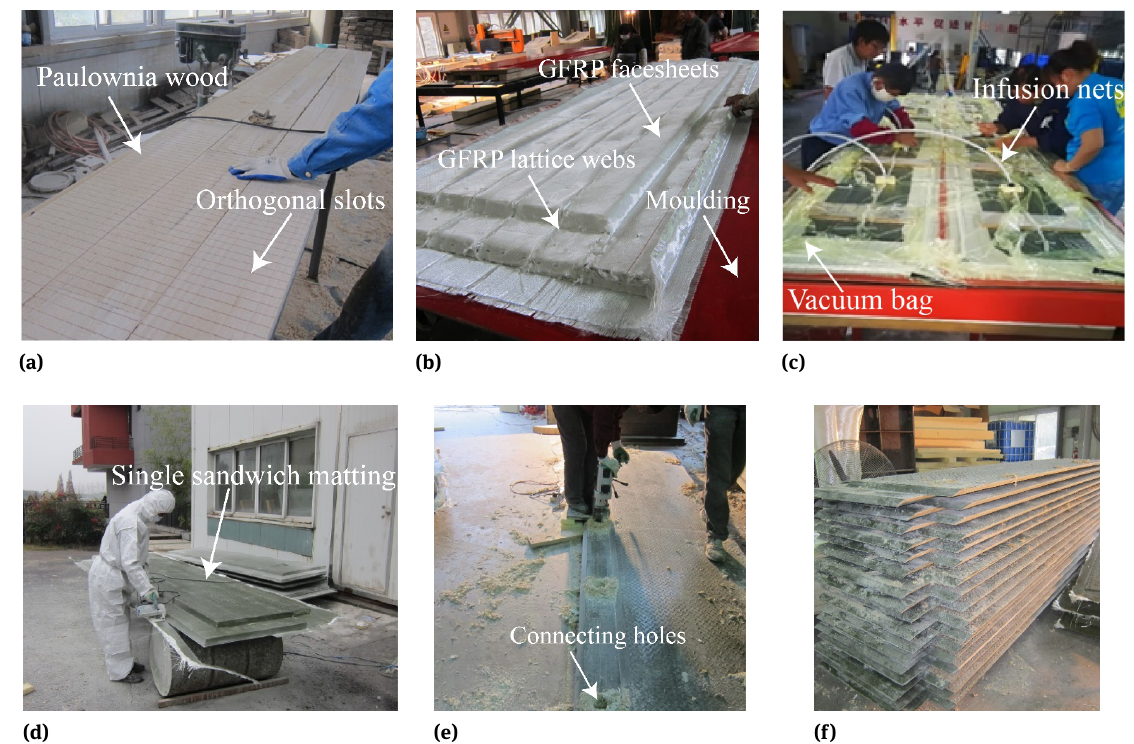
Figure 2: Fabrication process of the sandwich matting. (a) prepared the paulownia wood core, (b) glass fabric to wrap the prepared core, (c) VIMP, (d) demolding, (e) drill the holes, (f) photo of the fabricated sandwich